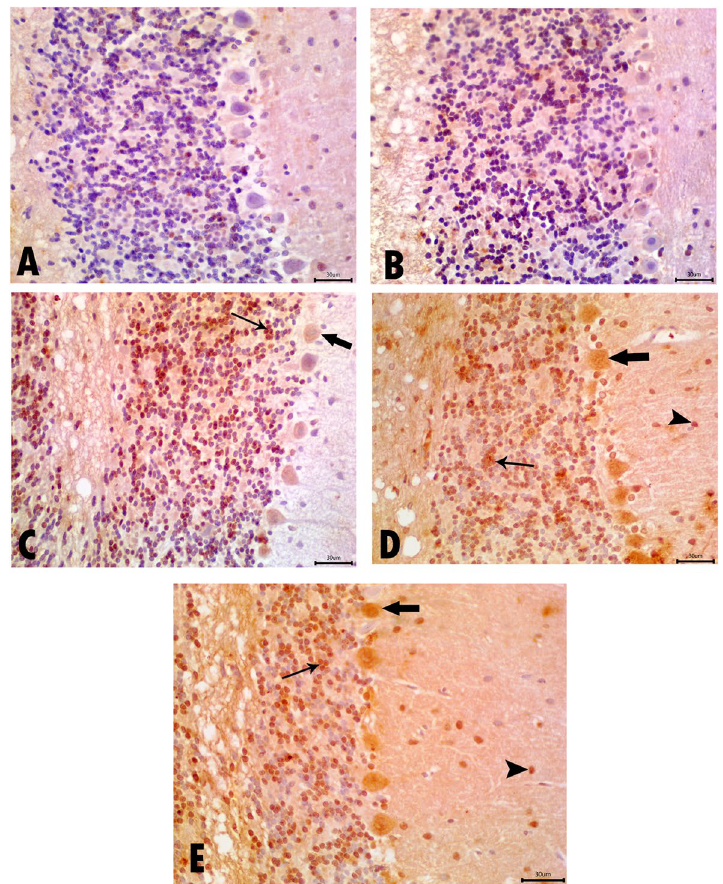
Fig. 6 Photomicrographs of sections in the cerebellar cortex immunohistochemically stained with inducible nitric oxide synthase (iNOS) ( and B Negative and positive control groups show a negative reaction in the cerebellar cortex. C The acute treated group shows positive cells mainly in Purkinje cell (thick arrow) and granular cell layers (arrow). D and E Chronic treated and chronic withdrawal groups reveal strong positive reactions in cells of granular (arrow), molecular (arrowhead), and Purkinje cell layers (thick